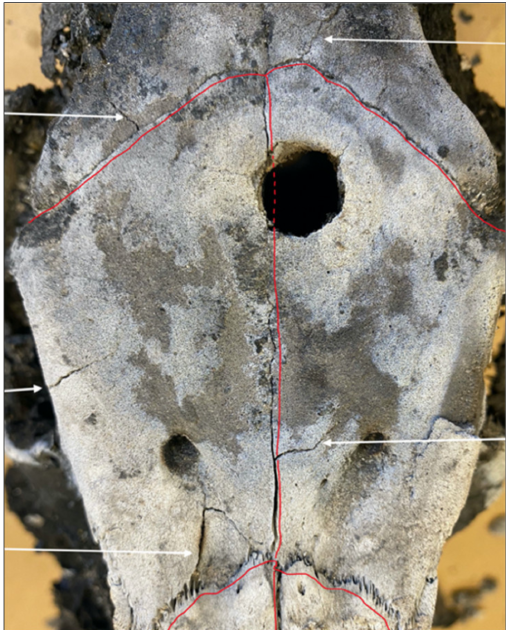
Figure 6. Red lines denote cranial sutures. White arrows point out thermal fractures originating and terminating within other sutures or foramina.